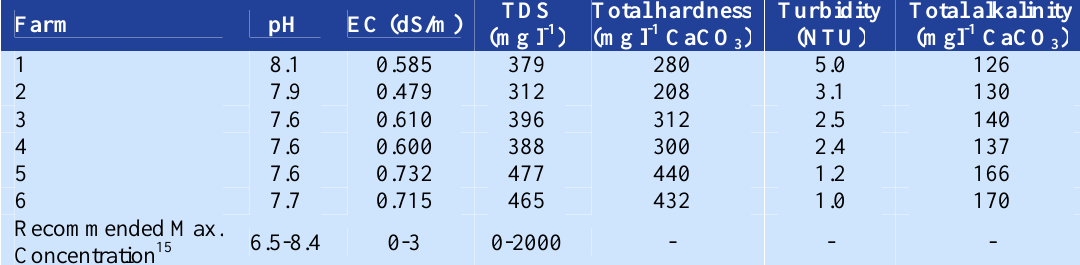
Table 1. Some properties of irrigation waters of vegetable farms Farm